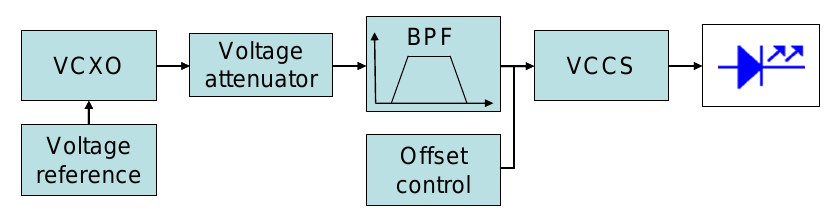
Figure 5. Emitter